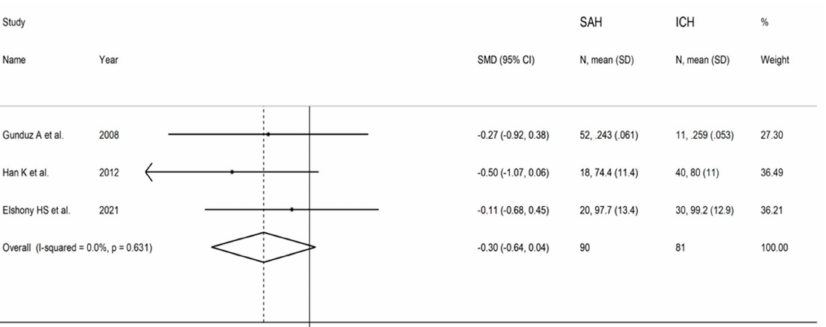
Figure 14. Forest plot of studies examining ischaemia-modified albumin values in patients with subarachnoid haemorrhage and intracerebral